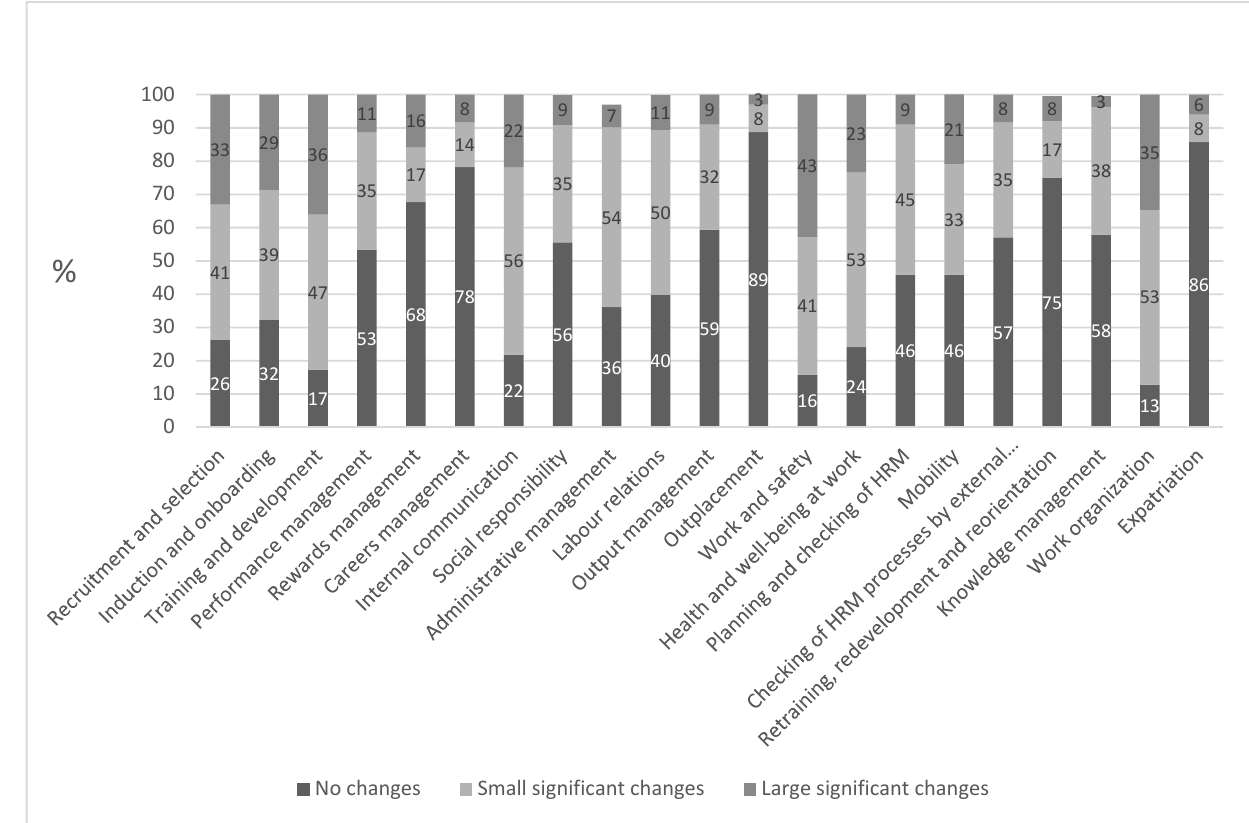
Figure 1. Changes in HRM practices and processes.